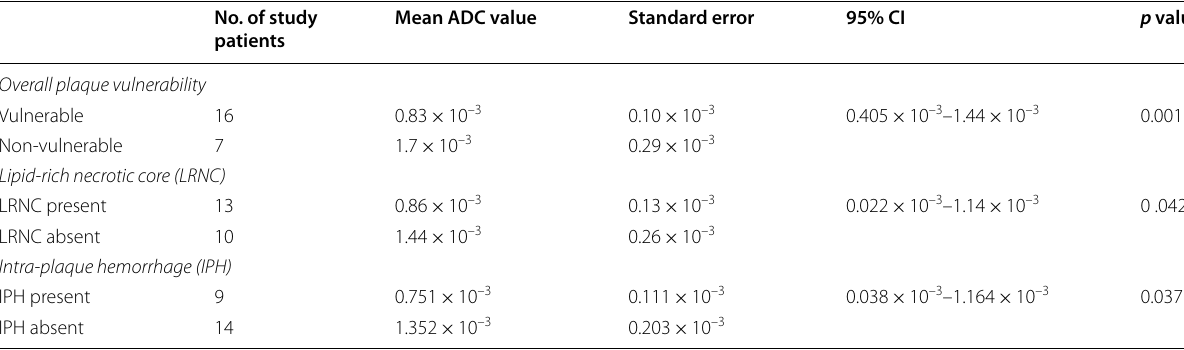
ADC apparent diffusion